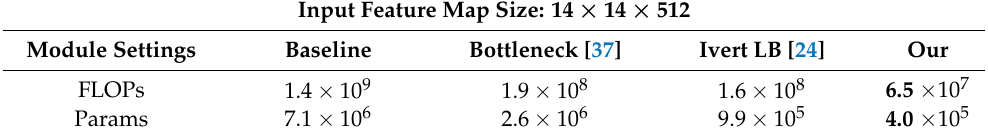
Table 2. Comparing the computation and parameters of different bottlenecks. The best scores are marked in bold.